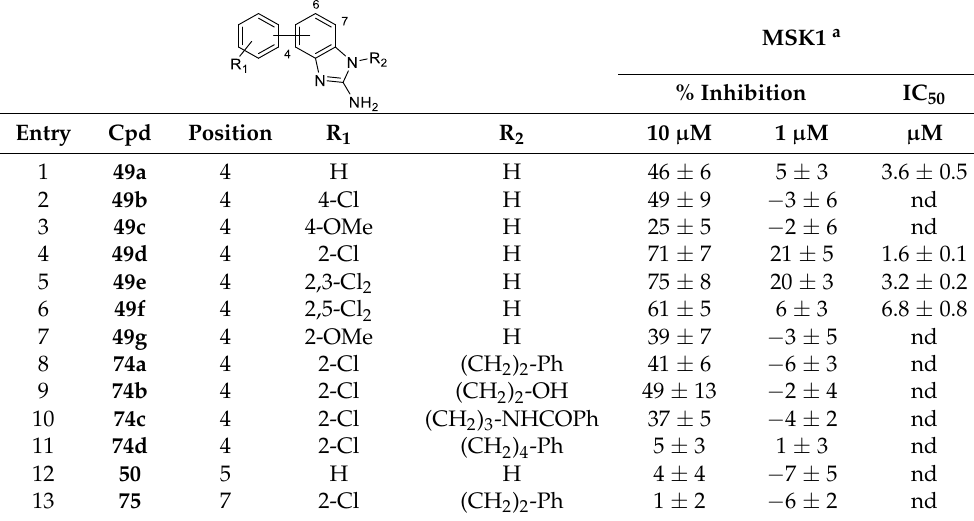
Table 5. Benzimidazoles derivatives.